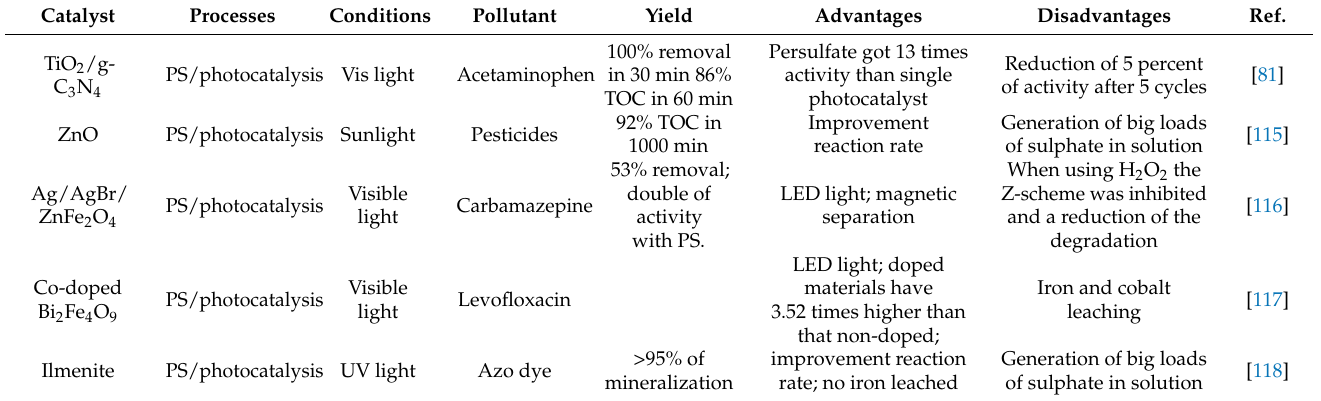
Table 8. Photocatalysts employed for persulfate